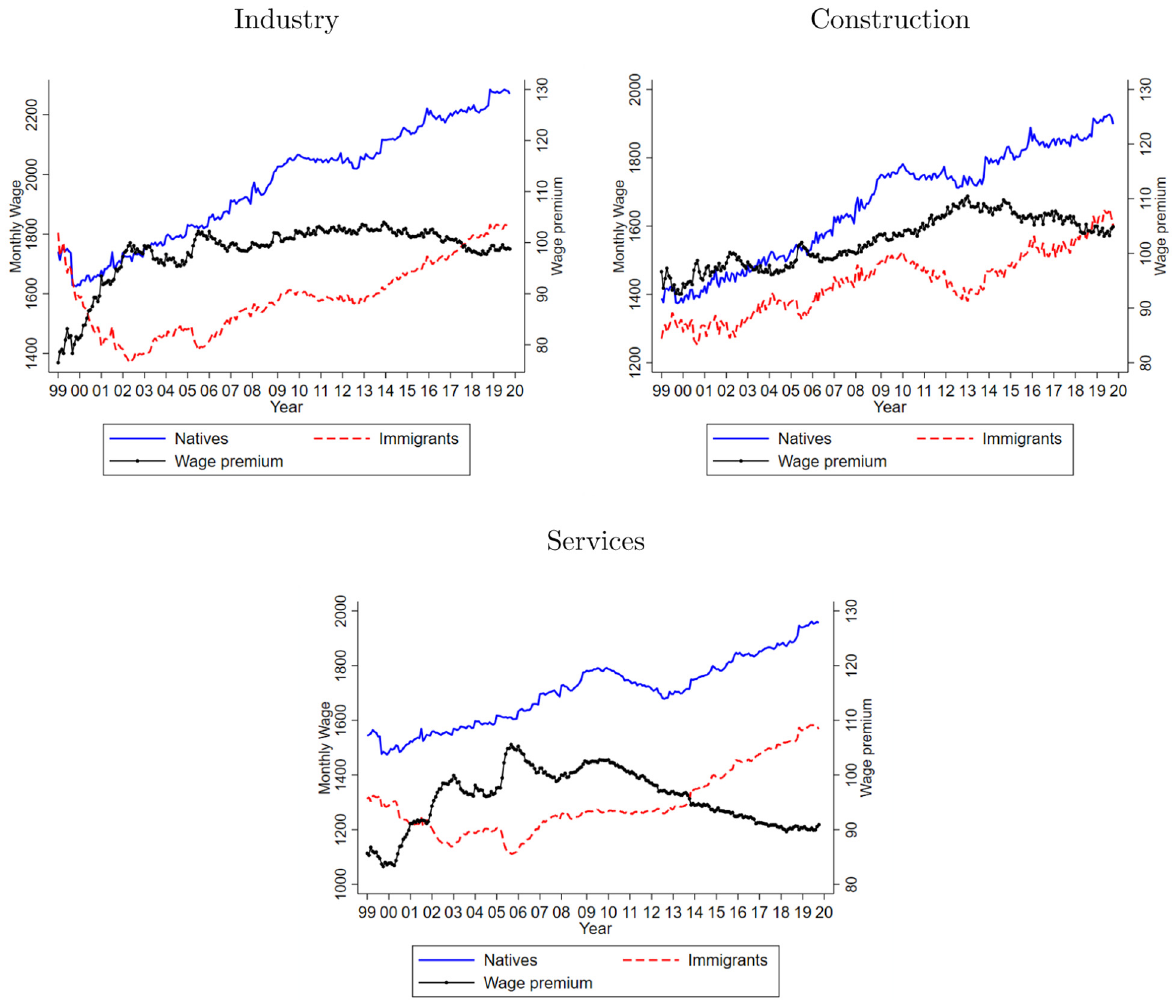
Figure 7: Monthly average wage by nationality and sector. Note: The wage premium is computed as ( average wage for natives = j N and immigrants = j M at month t . Wage premium is normalised to 100 at 2008Q1. Wages are seasonally adjusted by taking out the coe ffi cient of the monthly dummies from an OLS regression. Source: